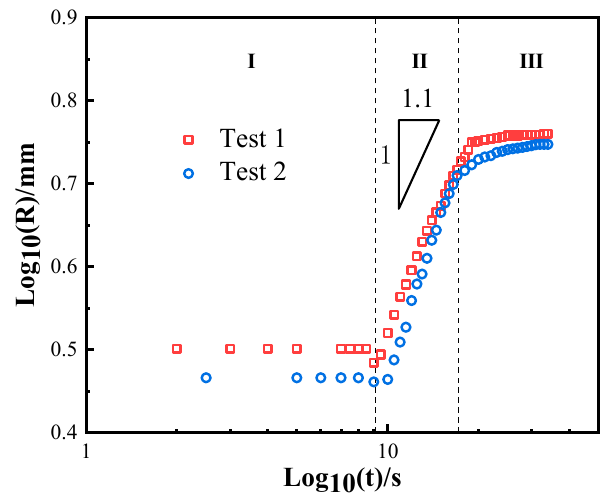
Figure 13. The logarithmic relationship between the equivalent expansion radius and time of the BNi2/TC4 system at 1080 °C.